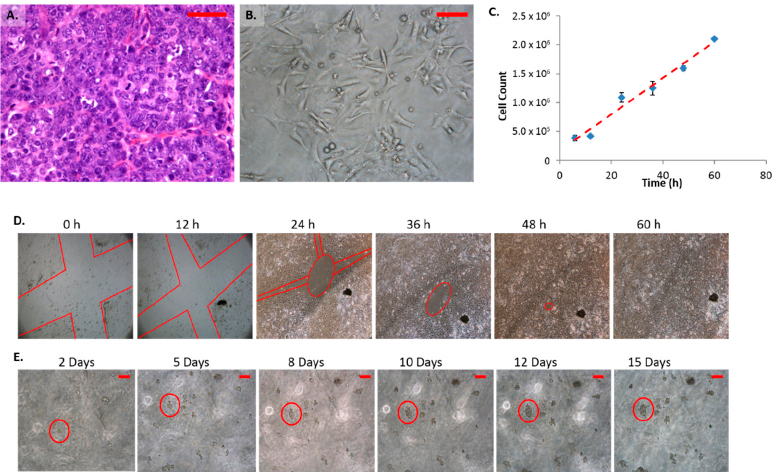
Figure 1. Characteristics of mammary carcinoma (FMC2u) cells. ( A ) H&E of primary tumor isolated